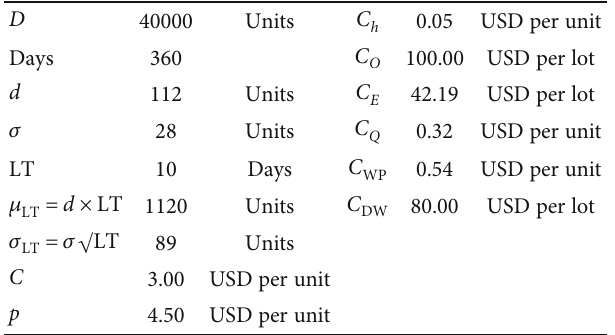
Figure 6: Route between supplier and retailer for the estimation of C Table 8: Overview of cost variables for the ( Q , R ) model with SD criteria.